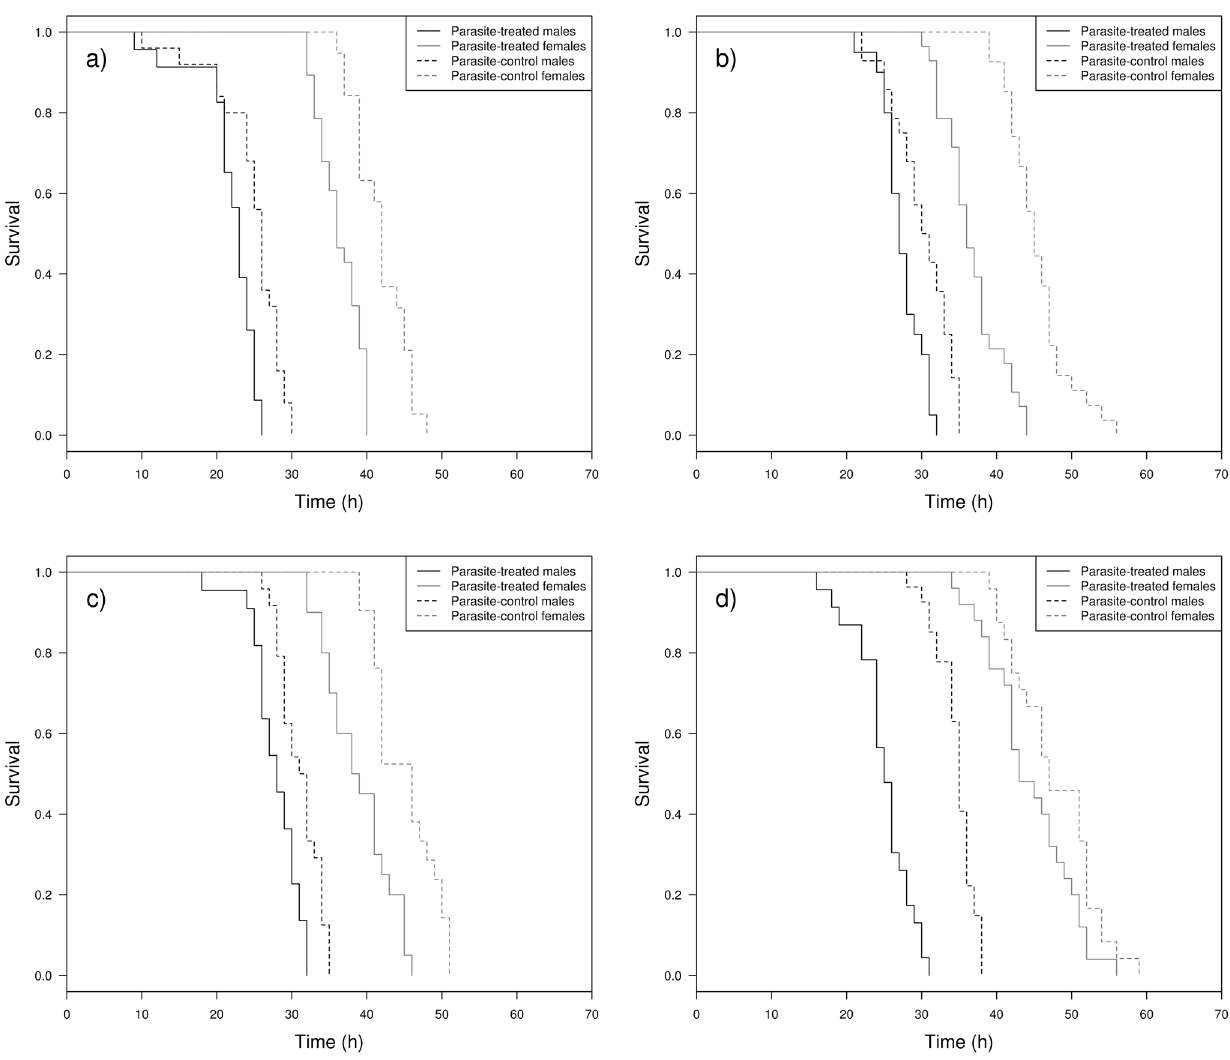
Figure 9. Survival and sex after infection. Kaplan-Meier survival curves according to species, sex and experimental infection interaction at age 3. a) Argia anceps , b) A. extranea , c) Hetaerina americana and d) Protoneura cara .